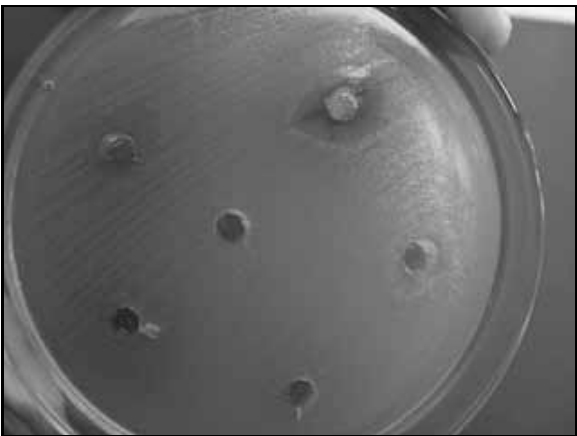
Figura 1 – Teste de sensibilidade da cultura de E. faecalis (ATCC 29212) ao extrato de quixabeira ( Syderoxylum obtusifolium [Roem et Schult.]) no ágar Muller-Hinton (Difco), decorridas 48 horas de incubação a 37 o